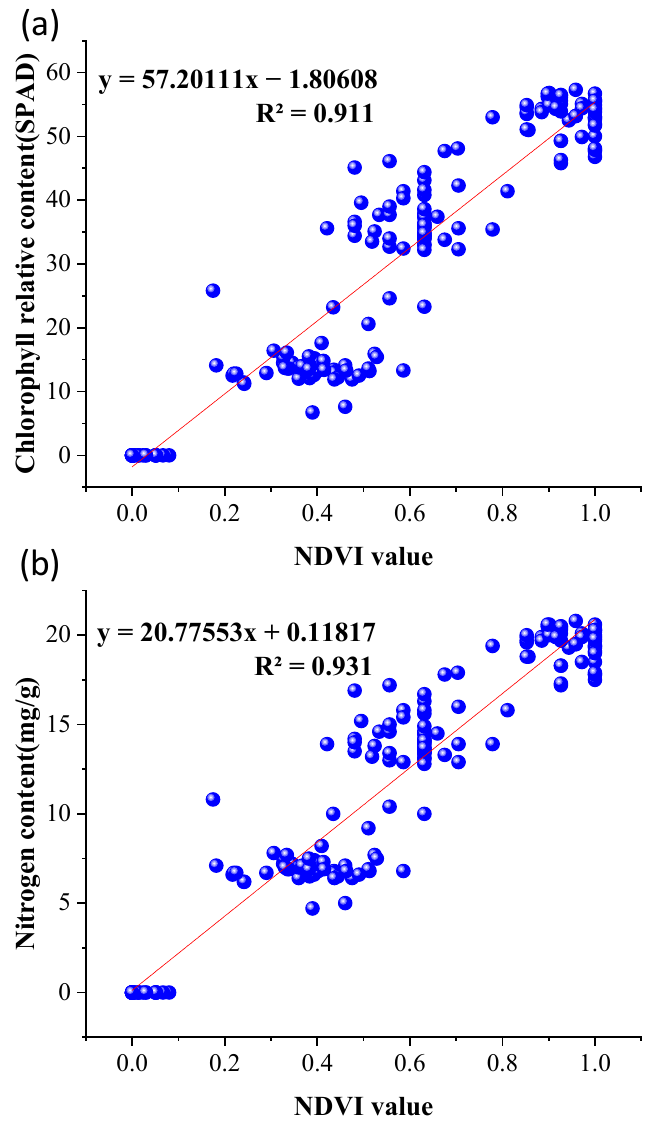
Figure 16. ( a ) Correlation between the NDVI and SPAD. ( b ) Correlation between the NDVI and NC.